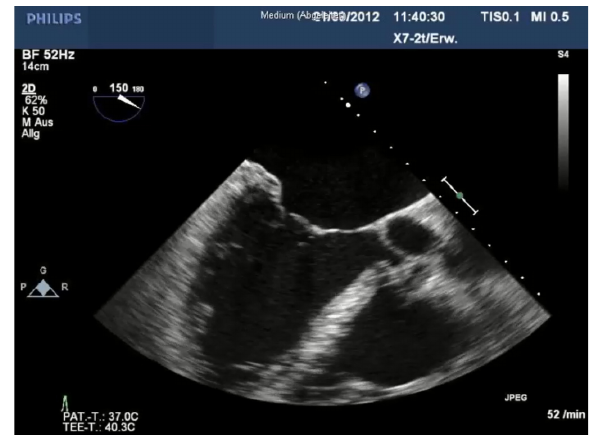
serve mitral regurgitation.